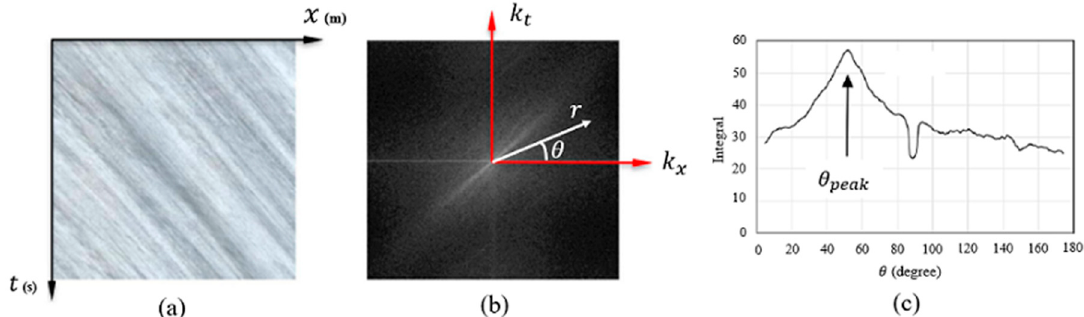
Figure 4. Process of the Fourier predominant angular analysis method: ( a ) original STI; ( b ) 2D Fourier transform image; ( c ) calculated radial intensity value integral for each angle.